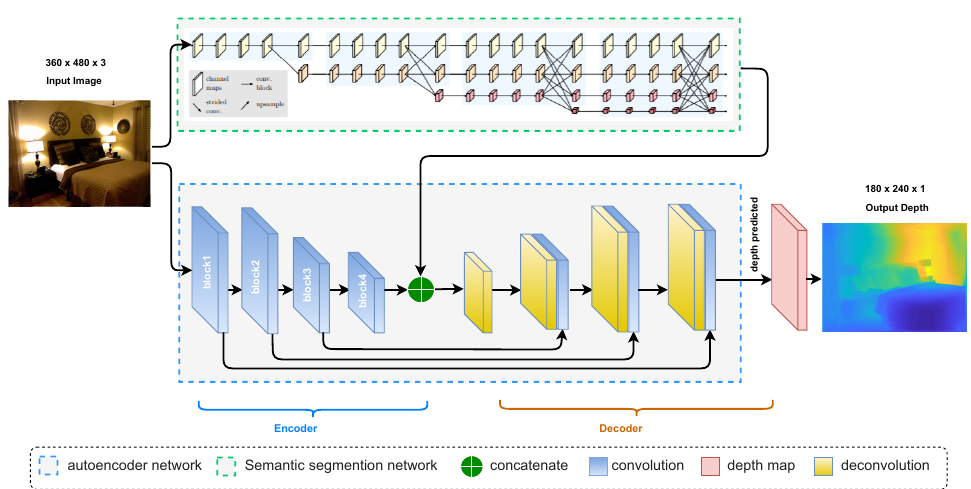
Figure 2. General overview of the proposed depth estimation